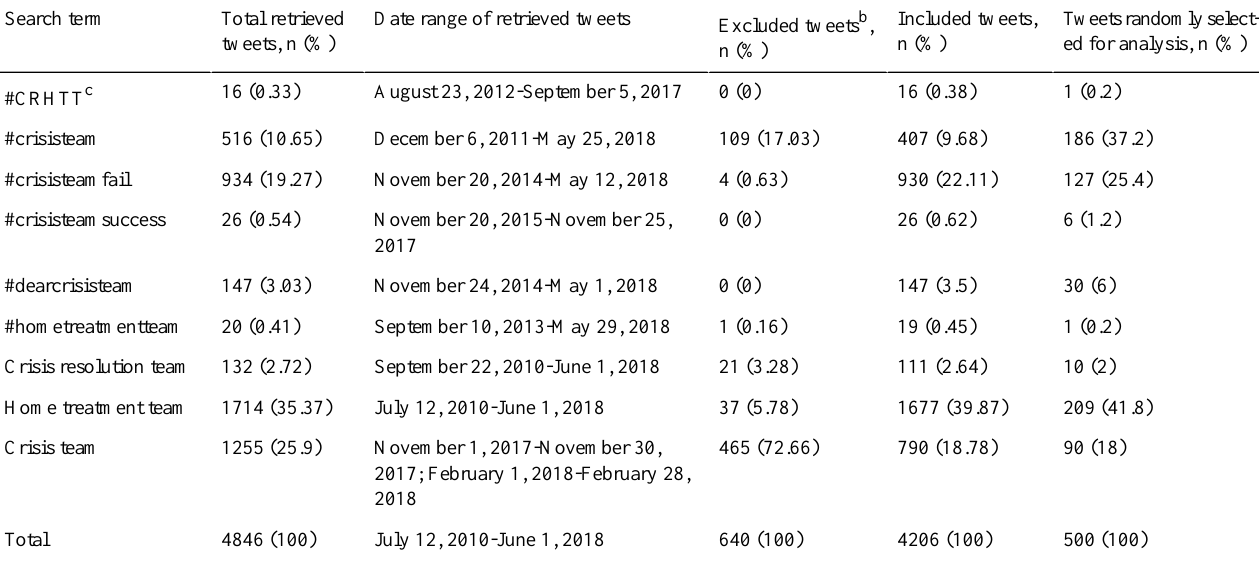
Table 1. Total number of tweets retrieved, excluded, and randomly selected for analysis by the search term a . (%)Search